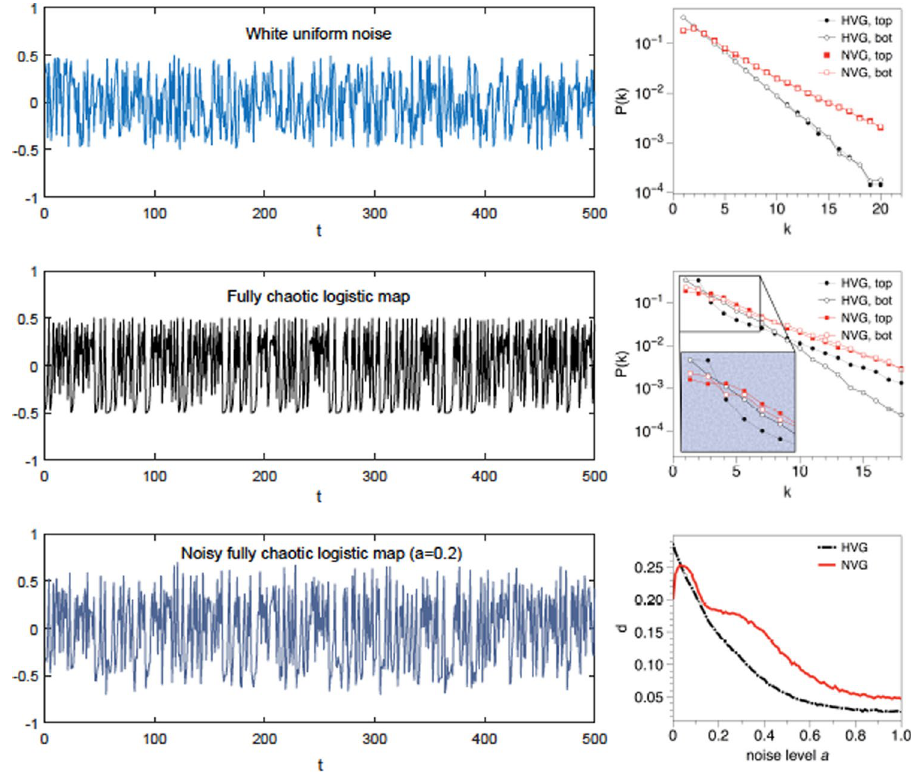
Figure 3. (Left panels) Sample time series of uniform white noise (top panel), fully chaotic logistic map (middle panel) and fully chaotic logistic map polluted with a certain amount of white noise (bottom panel). In all cases the signals are irregular and lack any obvious pattern (for appropriate visual comparison all signals have been scaled in the vertical axis). However, whereas the statistics of G top and G bot are equivalent for i.i.d., this is not the case for the chaotic process. In the last case, noise pollutes and hides the chaotic signal and as such the statistics of G top and G bot depend on the noise amplitude. (Right panels) Comparison of the degree distributions extracted from G top and G bot (for both VG/HVG). For the uniform white noise, distributions coincide as expected (the process is invariant under x ( t ) → − x ( t )). For the fully chaotic logistic series, statistics of G top and G bot are different and this feature introduces differences between local minima and maxima. In the last panel we plot the distance between distributions (using  norm) for a fully chaotic logistic map polluted with a certain amount of noise (see the 1